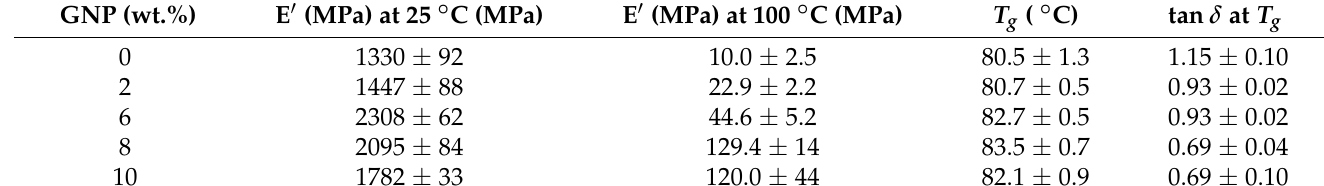
Table 2. Selected DMTA data for E (cid:48) , T g and tan δ of PET-GNP nanocomposites. GNP (wt.%)